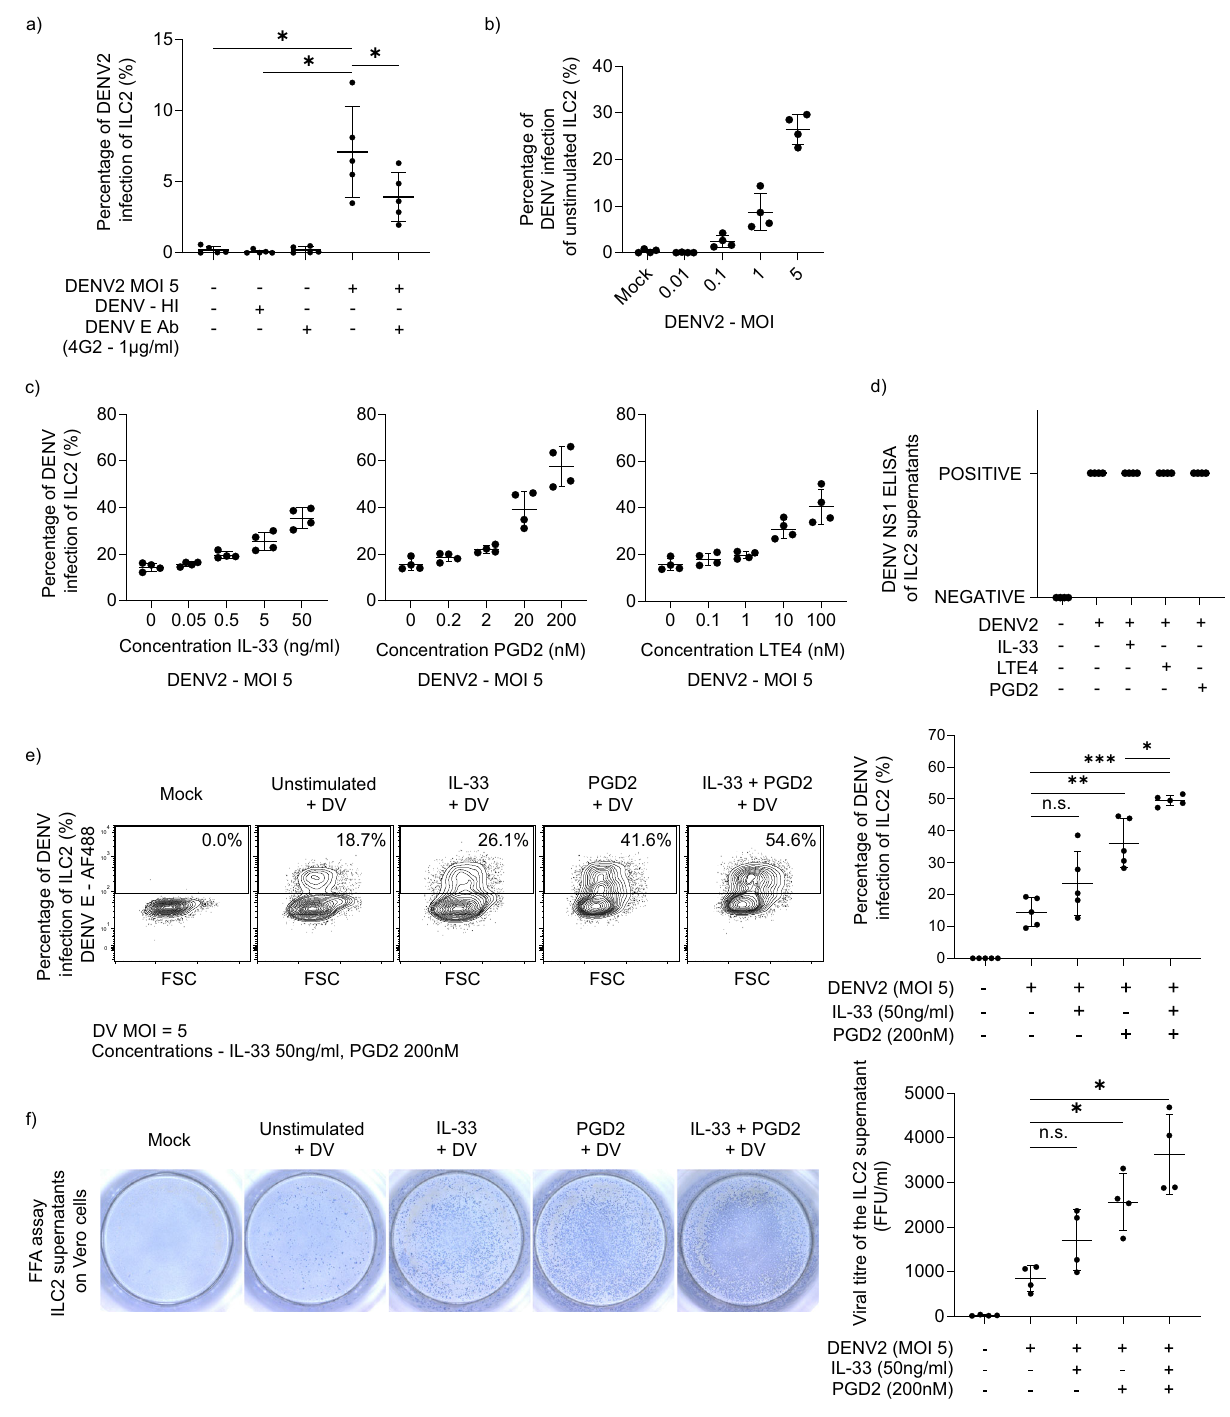
infection rates in an unstimulated state, and the infection signi fi cantly increased upon activation with PGD2 (Supplemen- tary Fig. 5b, c) and was signi fi cantly reduced with inhibition of CRTH2 receptor (Supplementary Fig. 5b, c). Supernatants from activated infected Th2 and Tc2 contained signi fi cantly higher infectious viral particles than unstimulated counterparts (Supple- mentary Fig. 5d). Compared to Th2 and Tc2 cells, ILC2 had signi fi cantly higher levels of dengue infection (Supplementary Fig. 5e) and virus production compared to Th2 or Tc2 or pan-T cells (Supplementary Fig.